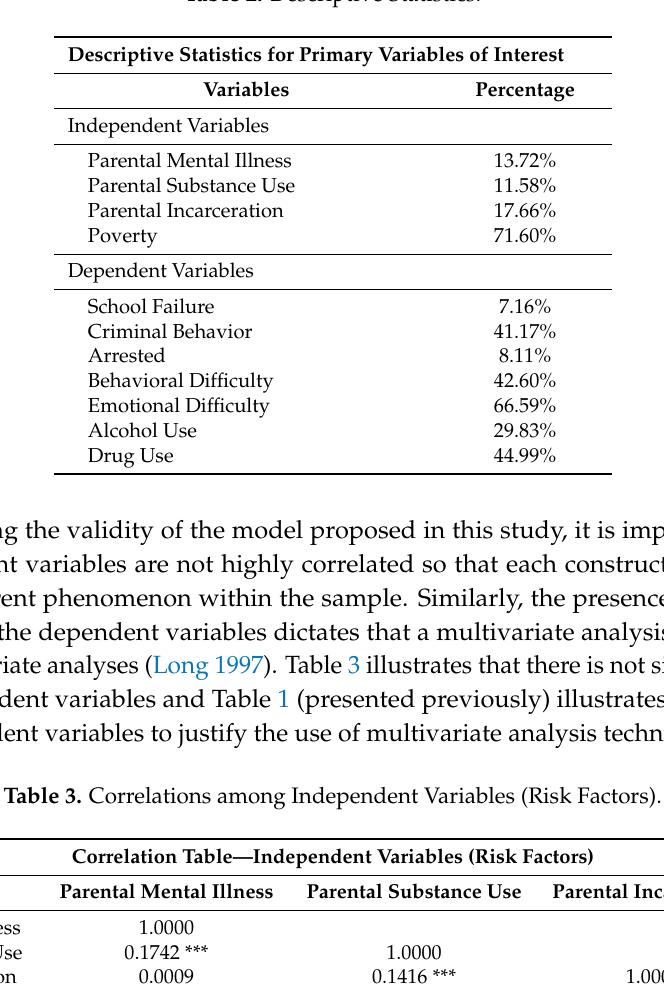
Table 2. Descriptive Statistics.